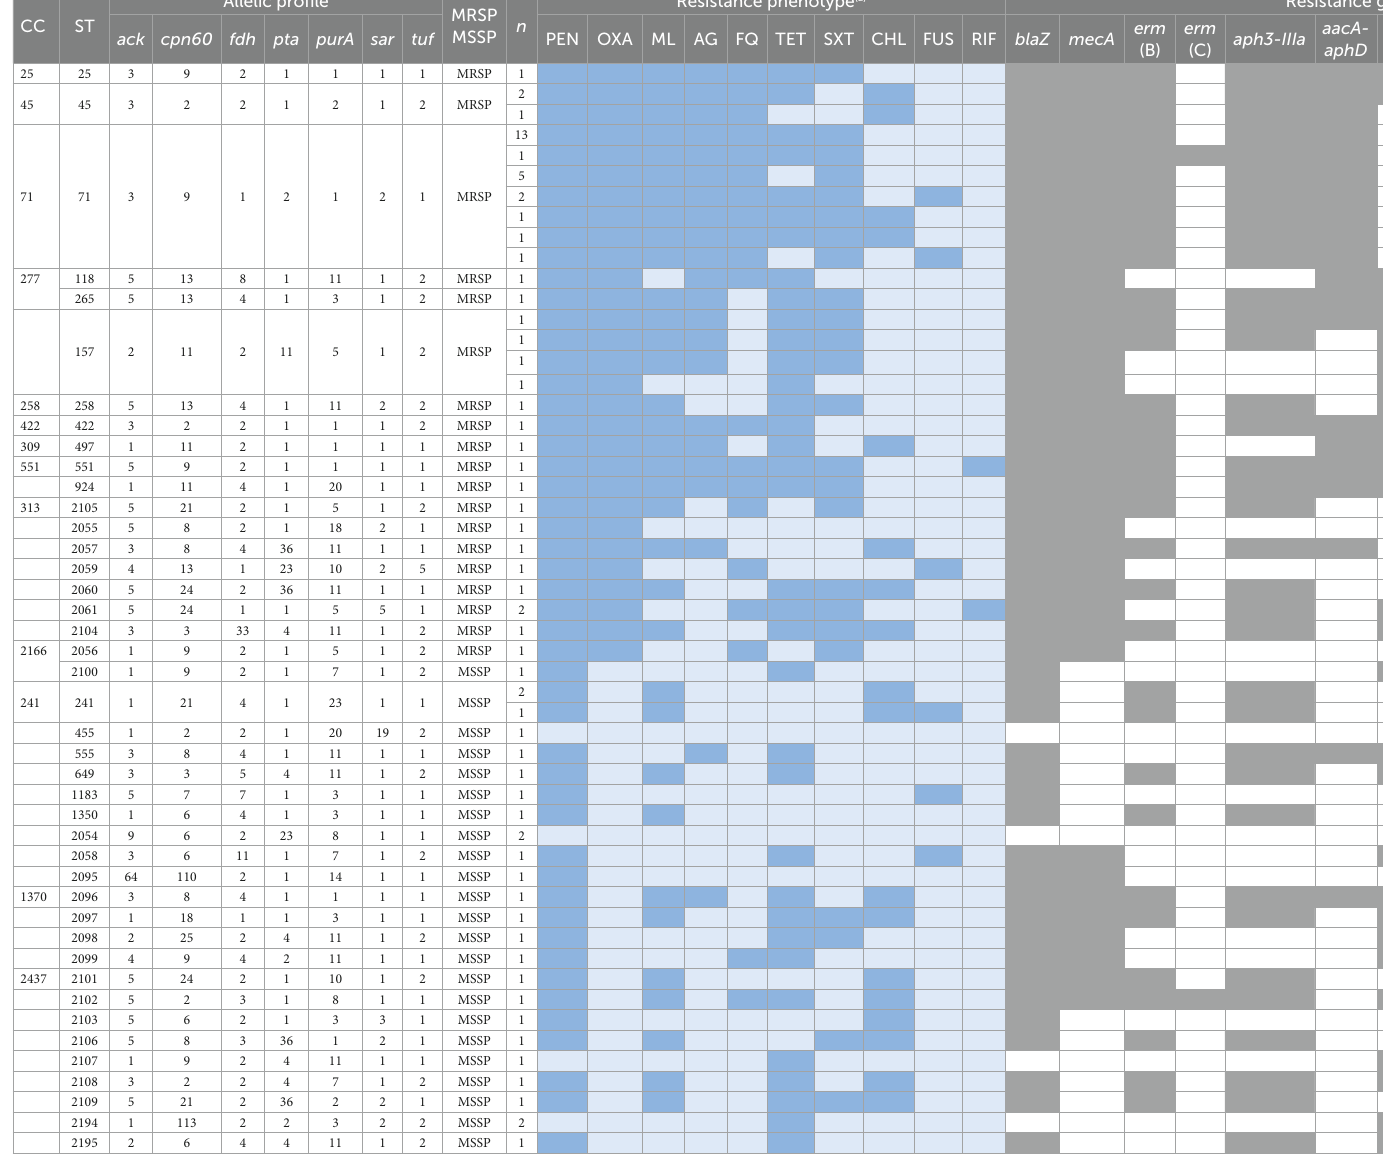
TABLE 3 Phenotypic and molecular characteristics of the MRSP and MSSP isolates typed by MLST. Allelic CC ST